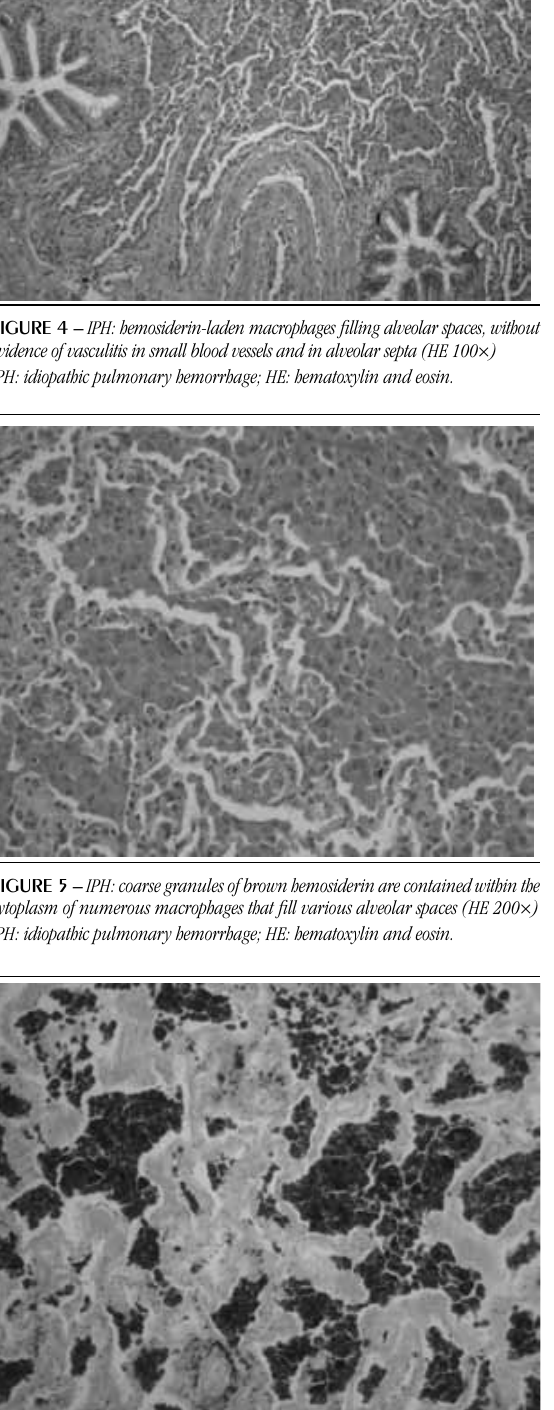
figurE 3 – IPH: hemosiderin-laden macrophages filling numerous alveolar spaces, without evidence of pathological changes in the wall of large blood vessels (HE 40×) IPH: idiopathic pulmonary hemorrhage; HE: hematoxylin and eosin.